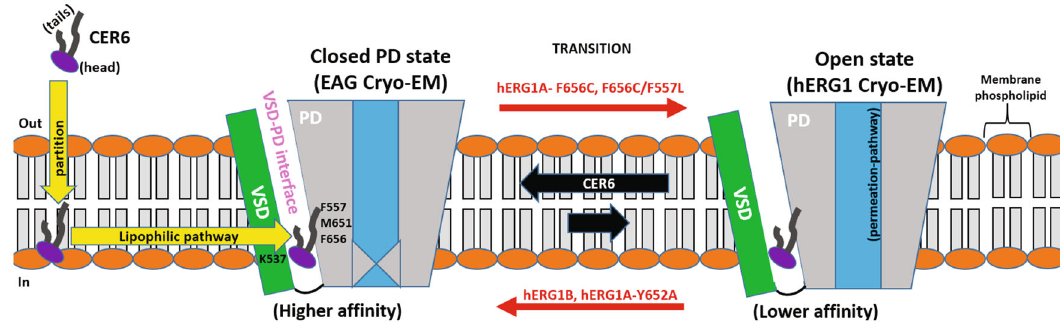
Fig. 4 Ceramides induce hERG1 block by a conformational selection mechanism through a lipophilic pathway. CER6 molecules partition into the membrane (after their application to the external milieu), followed by preferential binding to the interface between the voltage-sensing domain (VSD, green color) and the pore domain (PD, gray color) of hERG1 channels displaying a closed-state PD (only one of the four VSD – PD interfaces is shown). As a result, ceramides shift the population of hERG1A-WT channels towards the closed state (conformational selection), accelerating channel deactivation kinetics (left-pointing black arrow). The mutations hERG1A-F656C and F656C/F557L (right-pointing red arrow) affect ceramide interactions at the VSD – PD interface and induce slower channel deactivation kinetics, favoring the open state of the channel and the occurrence of residual currents (lack of complete channel block). In contrast, the mutation hERG1A-Y652A and the truncated N-terminal region in hERG1B isoform (left-pointing red arrow) induce faster deactivation kinetics, resulting in a higher population of ceramide-bound channels with closed-state PD and the lack of residual currents. Only two states are represented in this mechanism, corresponding to the two hERG1 channel structures used for MD simulations in this work: closed-state PD (homology model based on EAG Cryo-EM structure 7 , left ) and open-state PD (hERG1 Cryo-EM structure 10 , right ). Transitions at the VSD during activation and deactivation are not represented due to current structural-model limitations (see discussion). The ion permeation pathway in the PD of the channel is shown in blue color. Generic plasma-membrane phospholipids ’ headgroups and tails are colored in orange and gray colors,